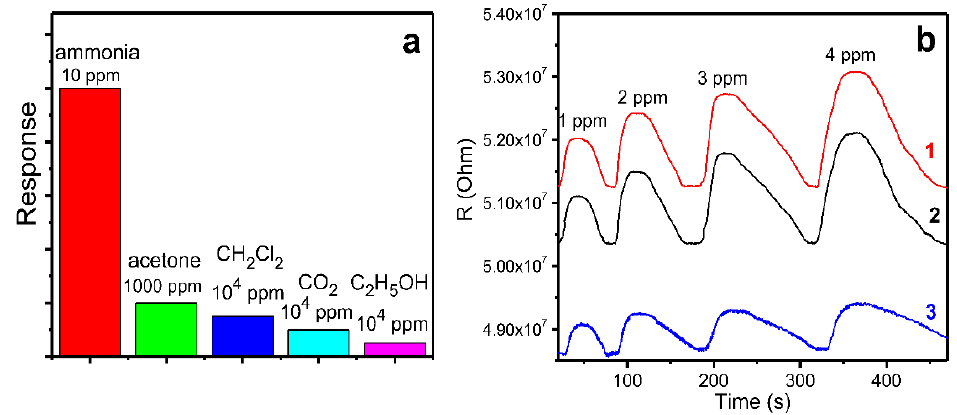
Figure 9. ( a ) Response of a ZnPcF 4 film to ammonia (10 ppm), acetone (1000 ppm), dichloromethane (10 4 ppm), carbon dioxide (10 4 ppm), and ethanol (10 4 ppm); ( b ) Response of a ZnPcF 4 film to ammonia (1–4 ppm) in air measured at relative humidity of 5% (1), 30% (2), and 70% (3).